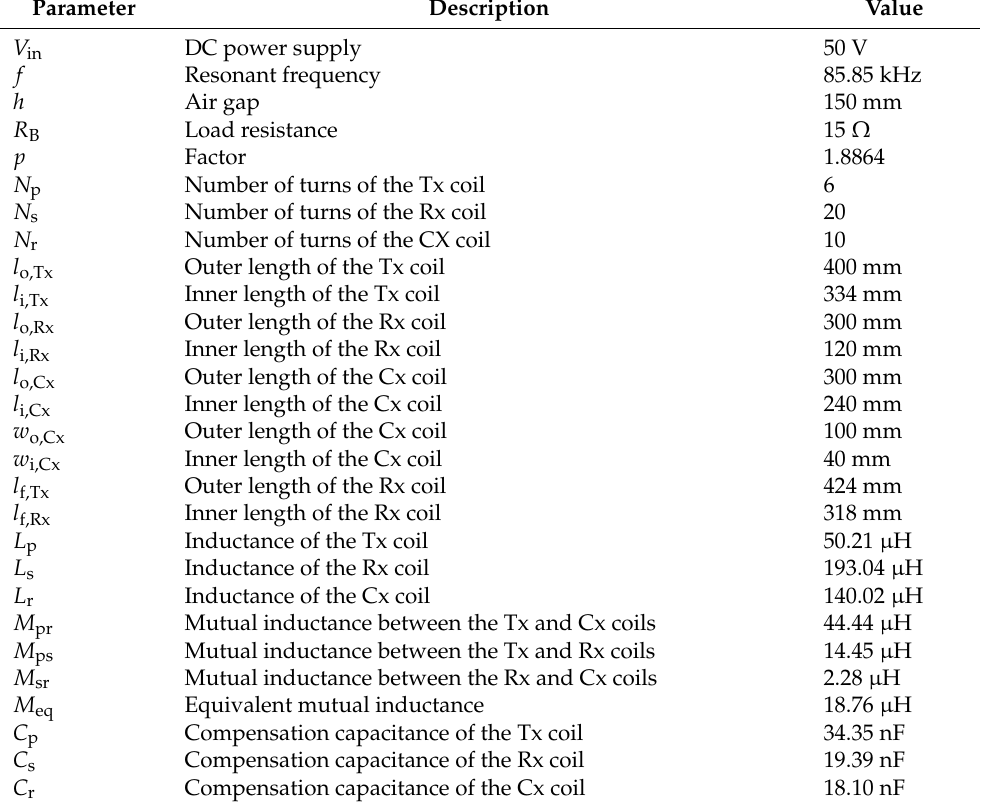
Table 2. Parameters of the proposed three-coil WPT system.